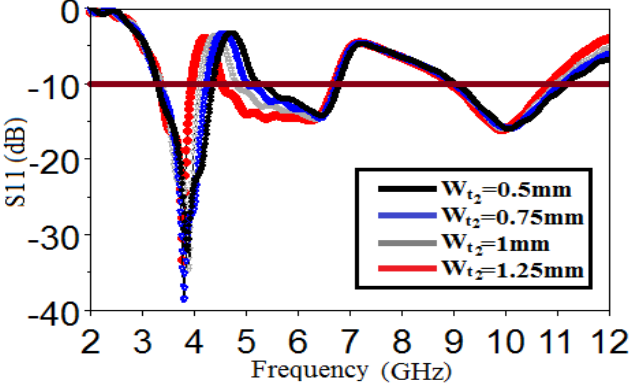
Figure 5: Simulated reflection coefficient for different Wt 2 Figure 6: Simulated reflection coefficient for different Lt 1 The Uplink and Downlink Eliminated X-band